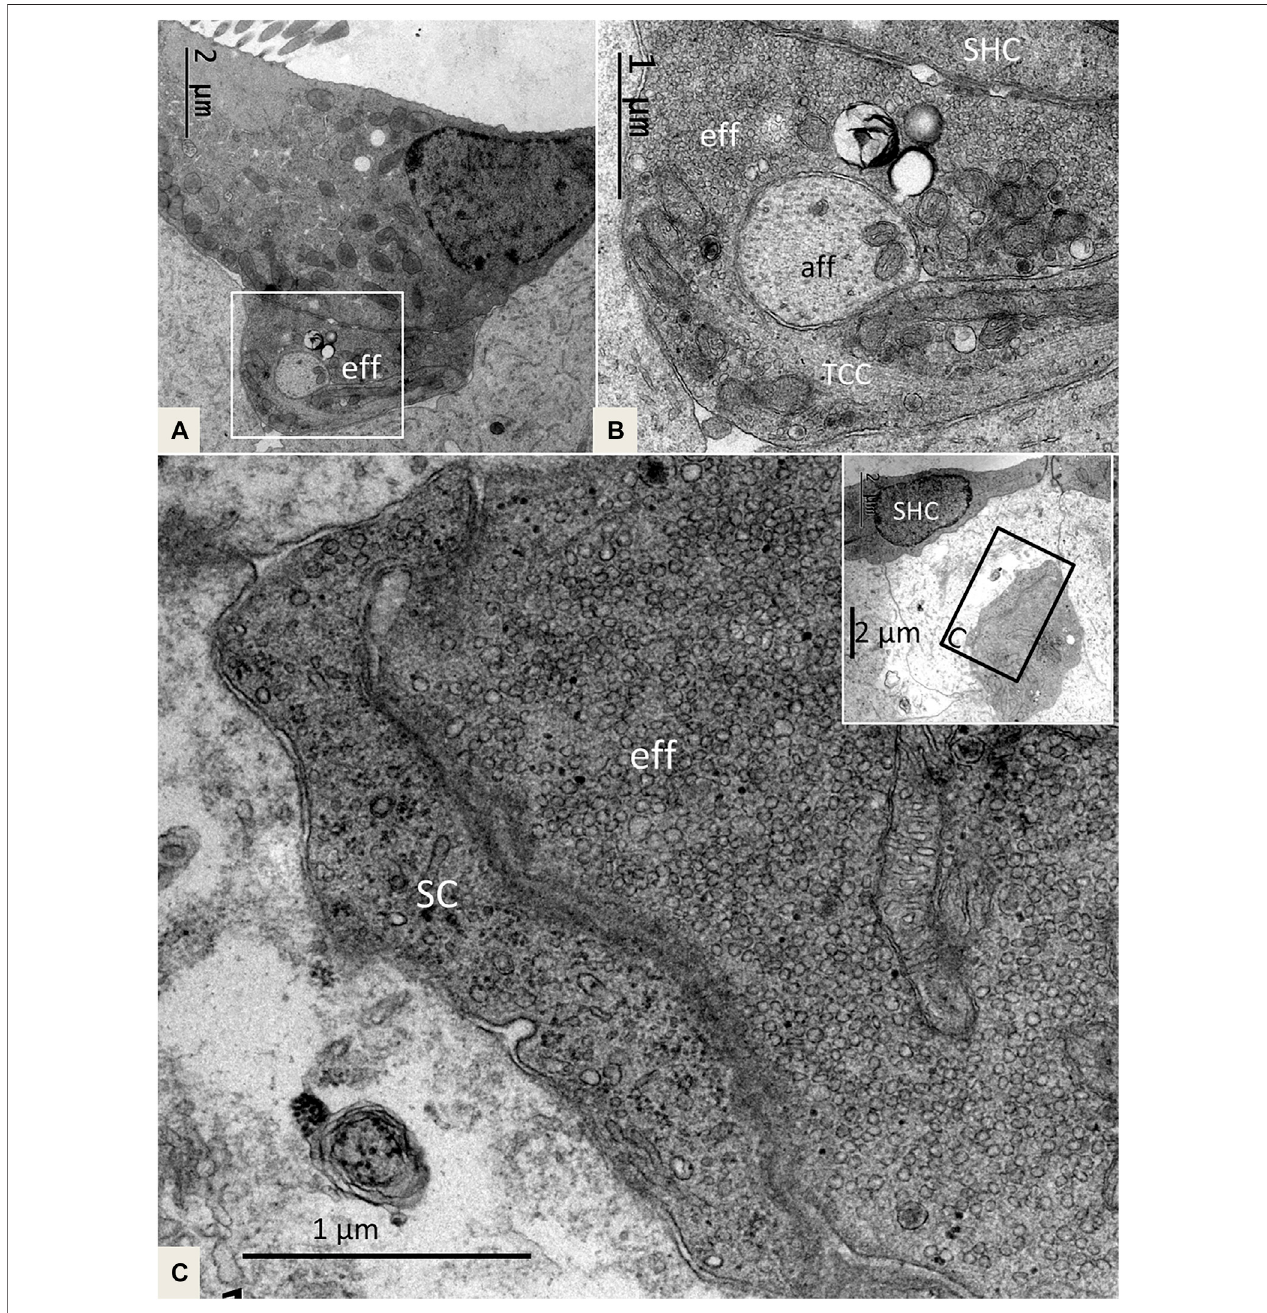
FIGURE 7 | (A) . SHC with an efferent terminal rich in secretory vesicles. Framed area is magni fi ed in (B) . (B) . The efferent terminal has folded and enwraps an afferent fi berinaso-calledemperipolesis.Theterminalcontainsmicro-tubulesoratranscellularchannelsystem(TCC).Eff:efferentnerve fi ber,aff:afferentnerve fi ber. (C) and inset. A large efferent swelling is located freely in the extracellular tissue beneath an SHC. It is associated with an electron-dense SC.